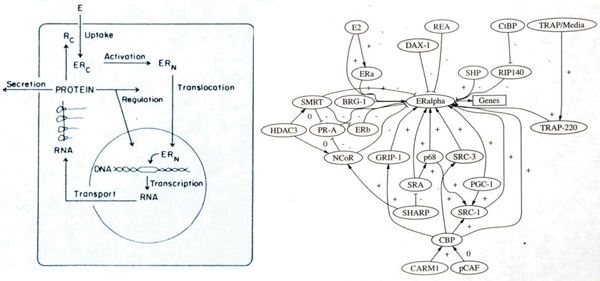
A depiction of estrogen receptor interaction almost 25yrs ago (left panel) [19] and a current view of estrogen receptor interactions (right panel) [23,25].